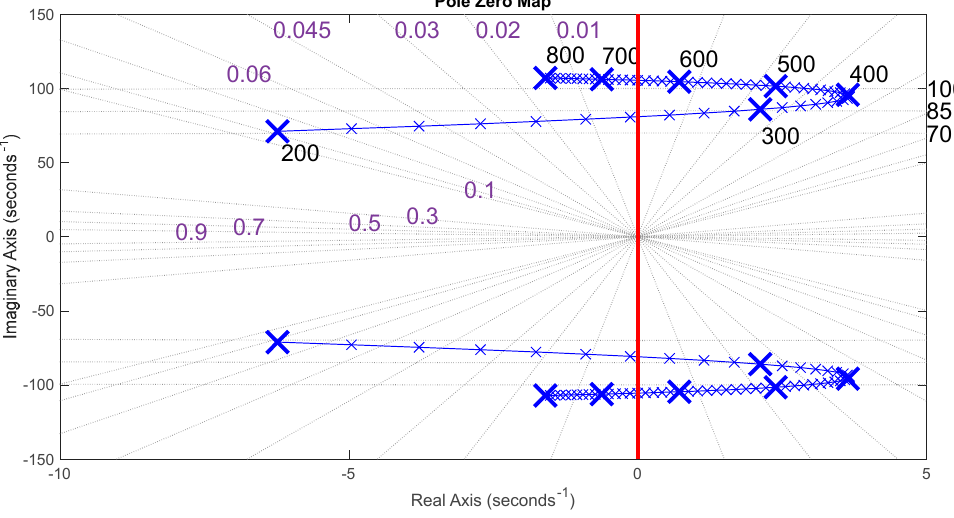
Figure 10. Small-signal model-based root locus with respect to the generator speed (blue crosses) with a bandwidth of 0.9 Hz for the gas turbine speed control.